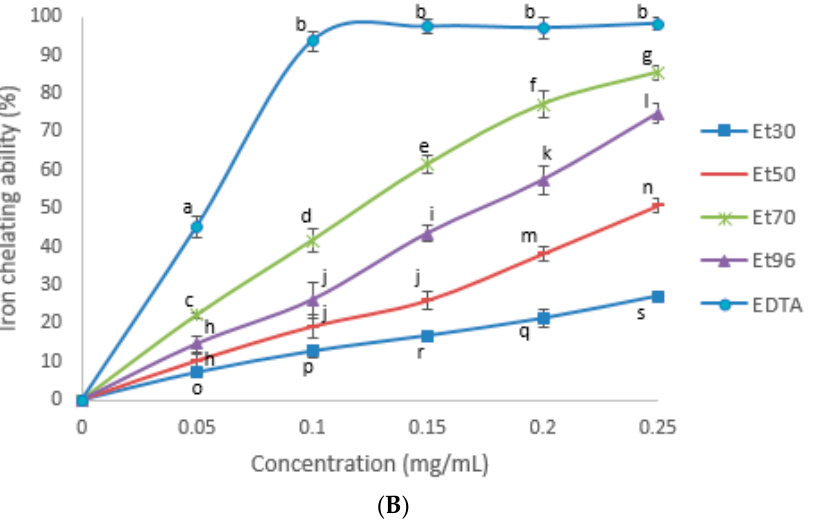
Figure 5. Iron chelating ability (%) of EDTA and the seed extracts of FSV ( A ) and FWV ( B ) at different ethanol concentrations in the extract solutions. Means not bearing a same letter are significantly different ( p < 0.05). EDTA = Ethylendiaminetetraacetic acid. Treatments: Et30 = extract with 30% ethanol; Et50 = extract with 50% ethanol; Et70 = extract with 70% ethanol; Et96 = extract with 96% ethanol. Table 4. IC 50 in iron chelating ability (mg/mL) of EDTA (standard) and the extracts of FSV and FWV seeds at different ethanol concentrations in the extract solutions. Variety of Fenugreek Treatments FWV FSV Et30 0.451 ± 0.024 a 0.494 ± 0.018 a